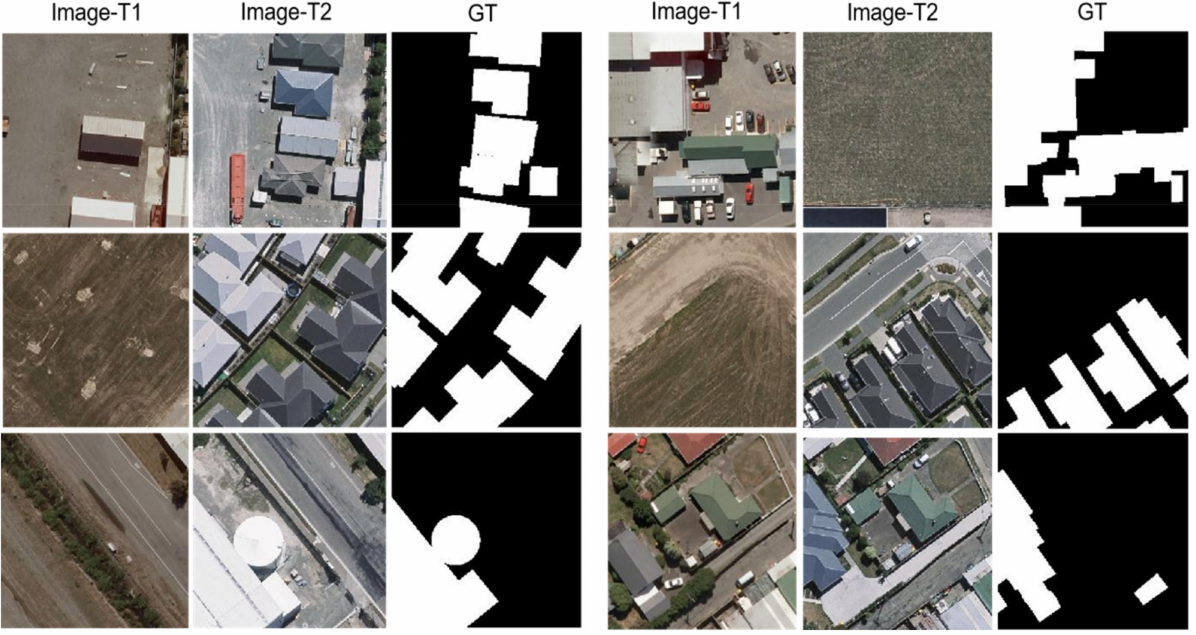
Figure 7. Illustration of samples from WHU-CD. (Image-T1) and (Image-T2) indicate the bi-temporal image pairs. (GT) indicates the ground